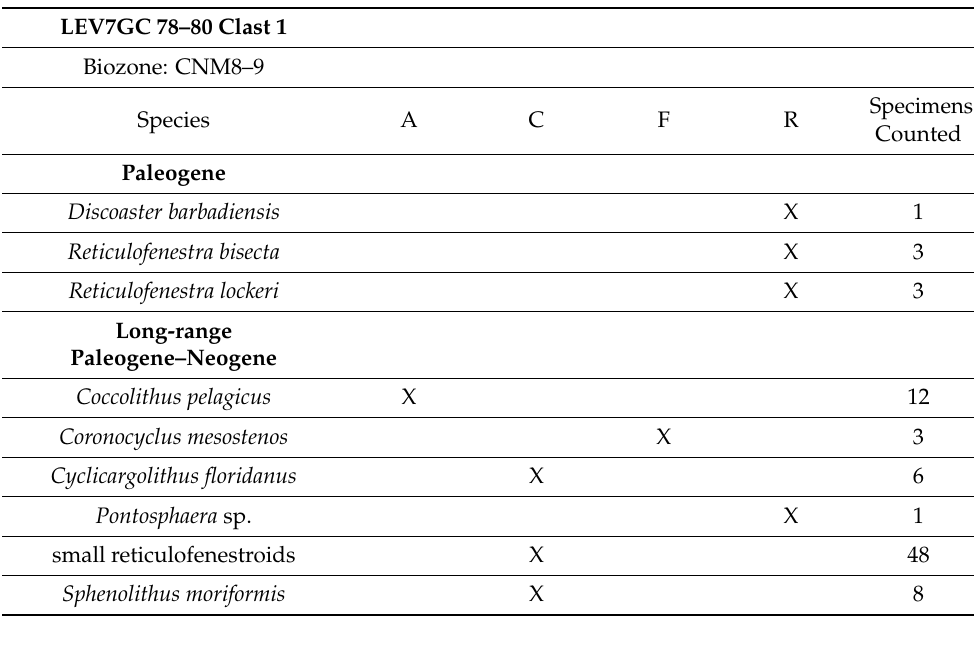
Table A35. Milano MV .